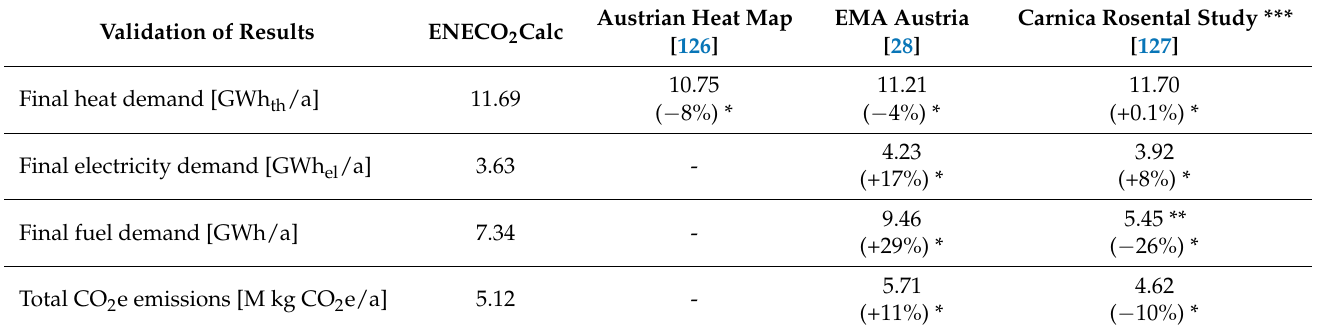
Figure 4. Final energy demand distribution of St. Margareten im Rosental for the year 2020. Table 3. Validation of present annual energy demand and CO 2 e emissions of St. Margareten im Rosental for the year 2020 with the literature